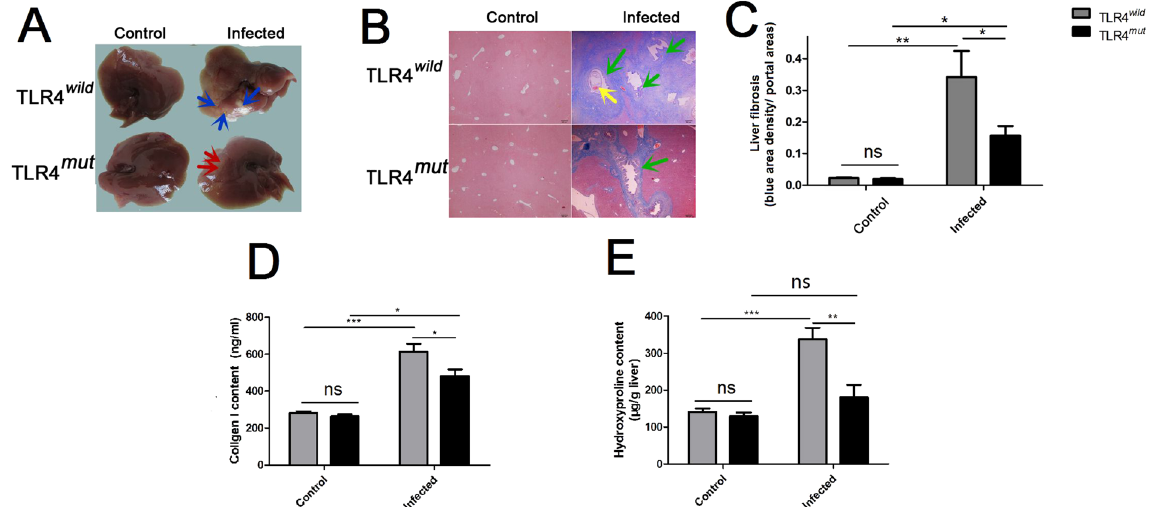
Figure 1. The mice with TLR4 mutation showed an attenuated pathogen-associated biliary fibrosis caused by Clonorchis sinensis . The mice with TLR4 wild and mutation were orally administrated by 45 metacercariae C . sinensis or PBS, respectively. These mice as well as healthy control mice were executed and livers were harvested on 28 days of C . sinensis post-infection. ( A ) Gross clinic hepatic changes of TLR4 wild and TLR4 mut C3H mice caused by C . sinensis . Blue arrows indicate massive nodules with different size in the hepatic lobes in the TLR4 wild mice infected by C . sinensis , and red arrows showed limited pale area on the surface of lobes without nodules in TLR4 mut mice, compared with TLR4 wild mice. ( B ) Representative Masson staining slides showed collagen fiber deposition (blue stripes). Scale bars = 200 μ m. Green arrows showed the proliferation of biliary epitheliums and enlarged the bile ducts in the mice of C . sinensis -infected mice, and the yellow arrow shows the worm’s body in the enlarged bile ducts. ( C ) The mean optical density of collagen fibers indicated by Masson staining was digitized and quantitated in the liver of healthy and C . sinensis -infected mice by on Image-Pro Plus software. ( D ) Concentrations of Collagen I in the hepatic homogenate of healthy control and C . sinensis - infected mice with TLR4 wild and TLR4 mut . ( E ) Concentrations of hydroxyproline in the hepatic homogenate of healthy normal control and C . sinensis -infected mice with TLR4 wild and TLR4 mut . The data were obtained from 3~5 mice of three-independent experiment. The values were expressed as mean ± SEM. compared with indicated group, * P < 0.05, ** P < 0.01, *** P <